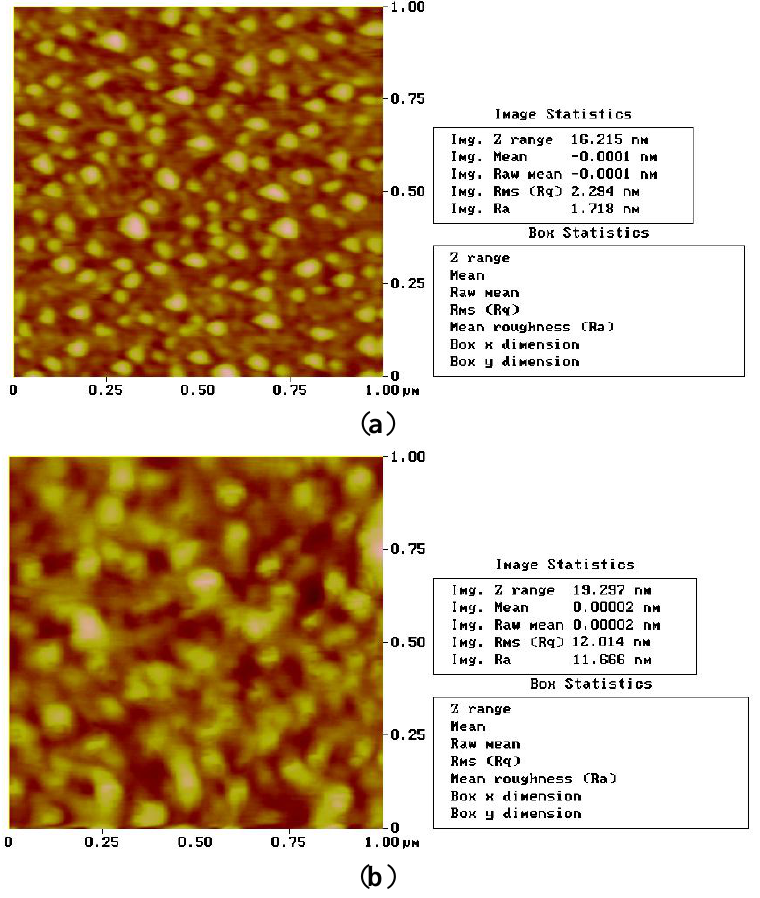
Figure 4. The 3D surface AFM photograph of SAW Au delay line. ( a ) Bare Au delay